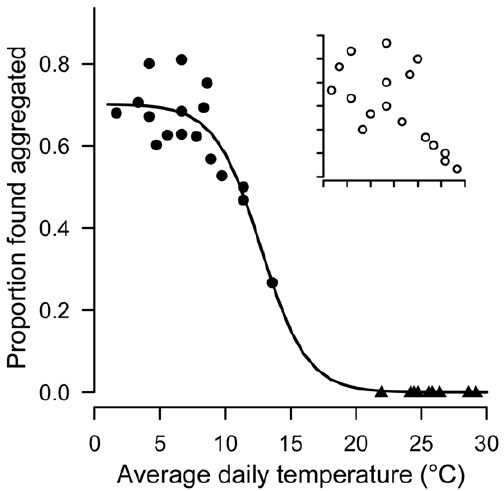
Figure 2. Social aggregation as a function of environmental temperature. The proportion of total lizards found aggregated each field collection day shows strong temperature-dependence ( N =17 winter [circles] and N =9 summer [triangles] days; sigmoidal function with both winter and summer points was only used to generate predictions of aggregation levels at unobserved temperatures, see Methods and Figure 4). Inset shows Spearman correlation among ranked winter days only ( r = 2 0.63, P